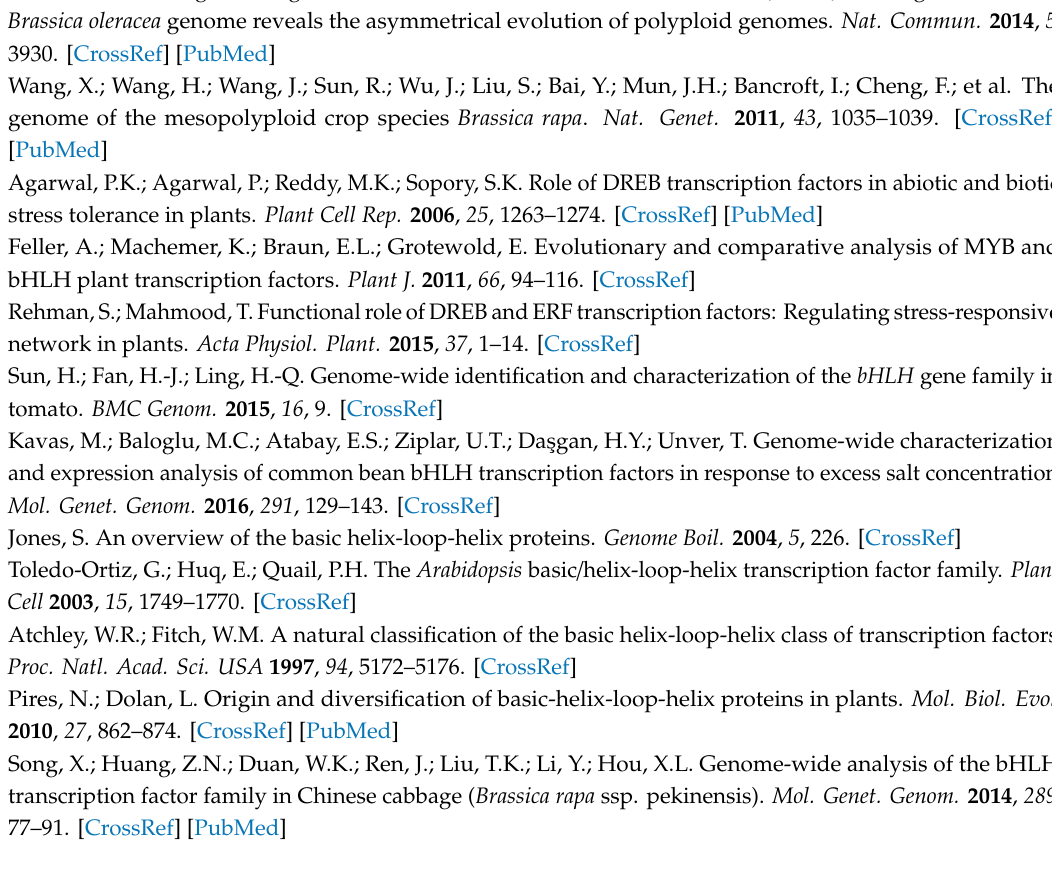
Table S1. The genomic sequences of the 234 BobHLH genes; Table S2. The coding sequences of the 234 BobHLH genes; Table S3. The protein sequences of the 234 BobHLH proteins; Table S4. The characteristics of BobHLH family in B. oleracea ; Table S5. Organ / tissue-expression FPKM values of BobHLH genes extracted from RNA-Seq data; Table S6. Chilling-expression FPKM values of BobHLH genes extracted from RNA-Seq data; Table S7. The characteristics of 234 BobHLH proteins in B. oleracea ; Table S8. The details of cis -acting elements in the 2000 bp upstream of the BobHLH genes; Table S9. Subcellular localization prediction; Table S10. Primers of vector construction. Figure S1. The distribution of conserved motifs in each BobHLH protein; Figure S2. Sequence logos of BobHLH proteins domains; Figure S3. The distribution of exon-intron in BobHLH genes. Author Contributions: Z.D. conceived and supervised the work. X.S. performed the bioinformatics analysis